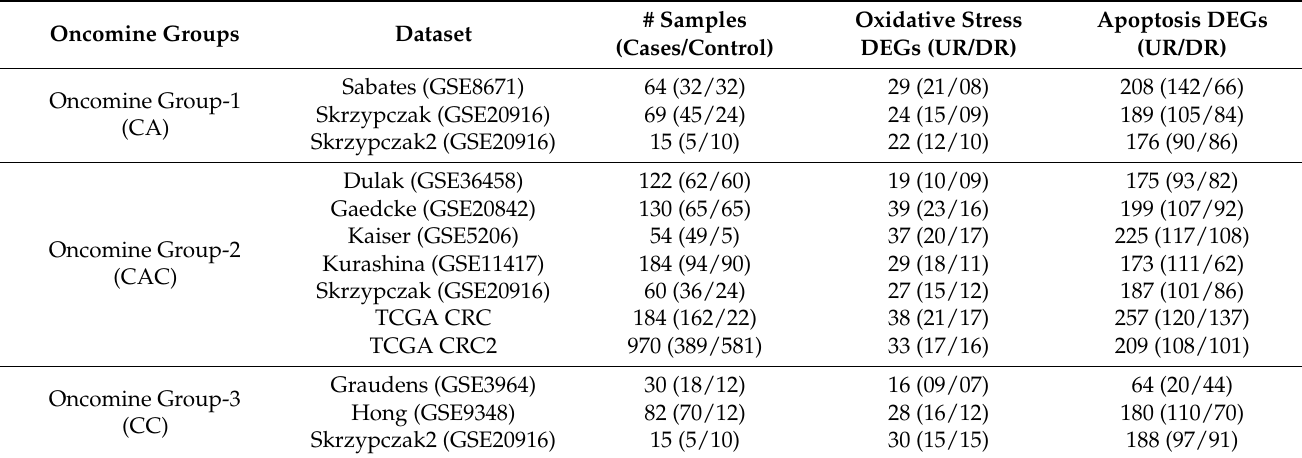
Table 2. Description of the Oncomine datasets used in this